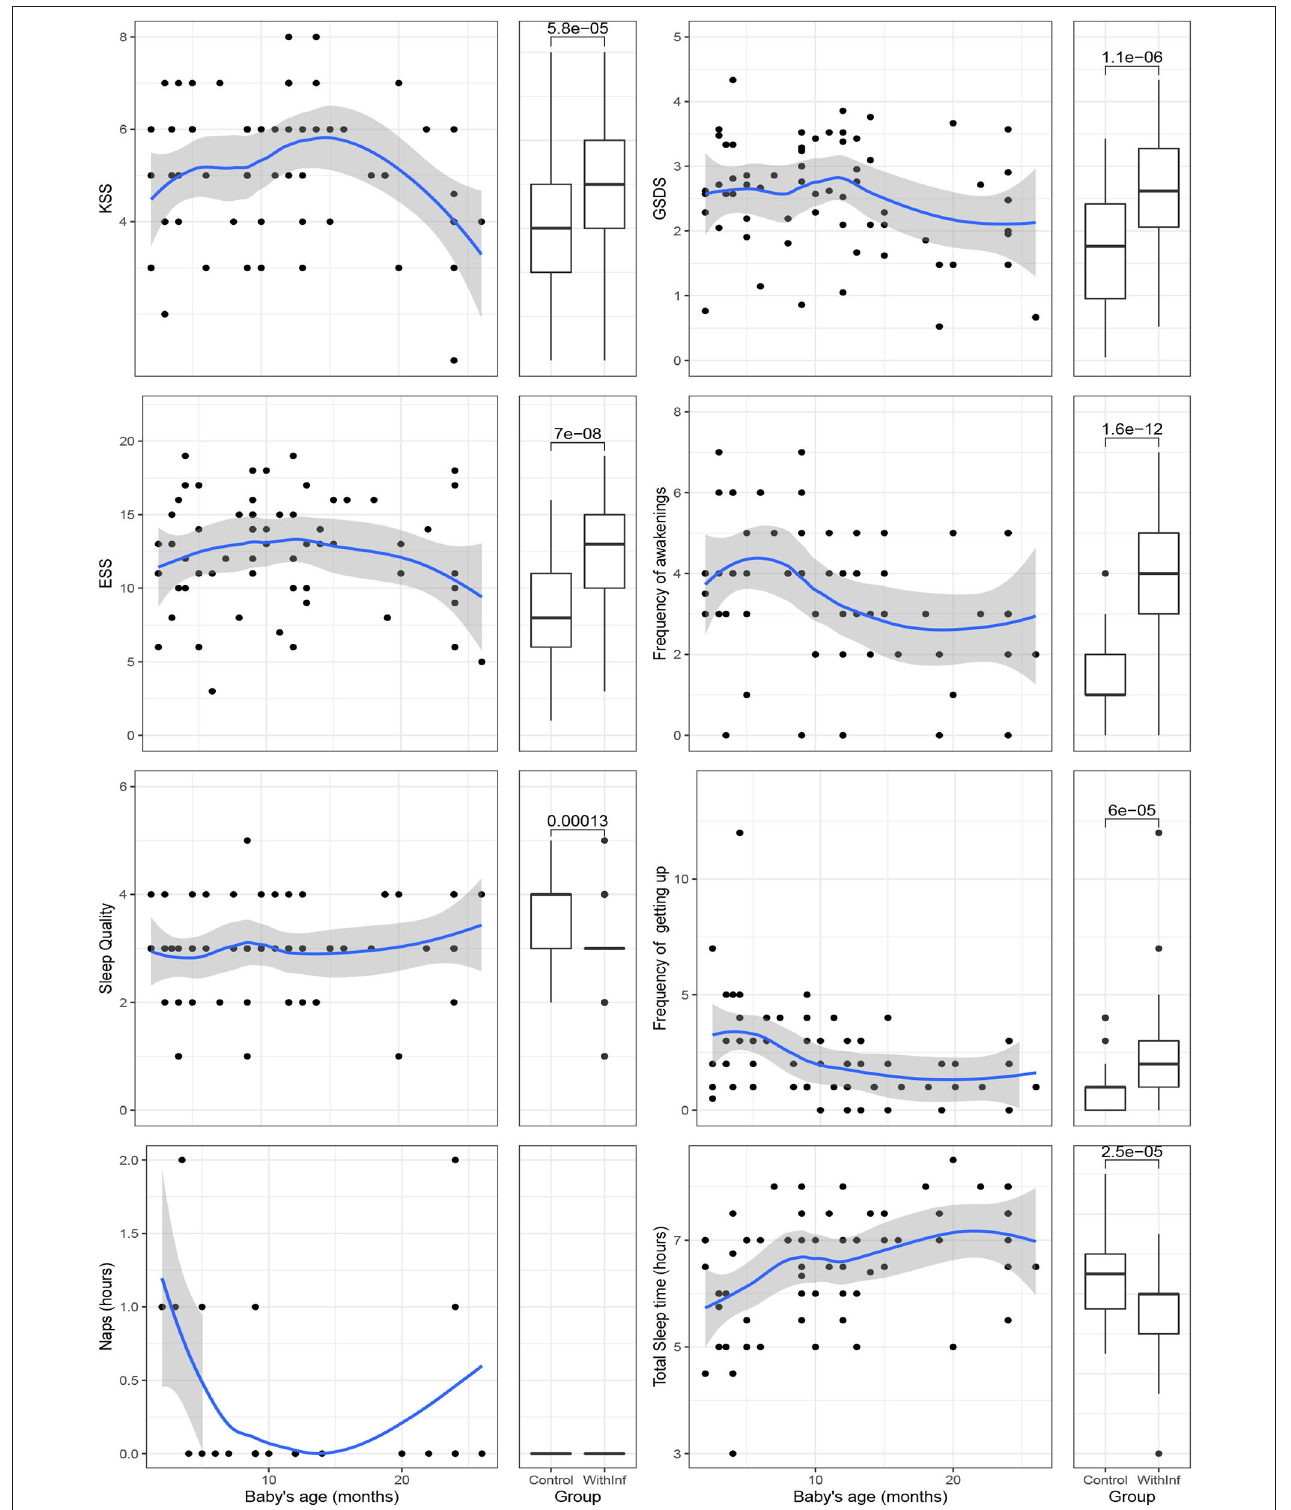
FIGURE 1 | Scatter plots showing relationship between sleepiness variables in mothers with babies of under 24 months old and the normal values of women without babies and box plots showing the same comparison.